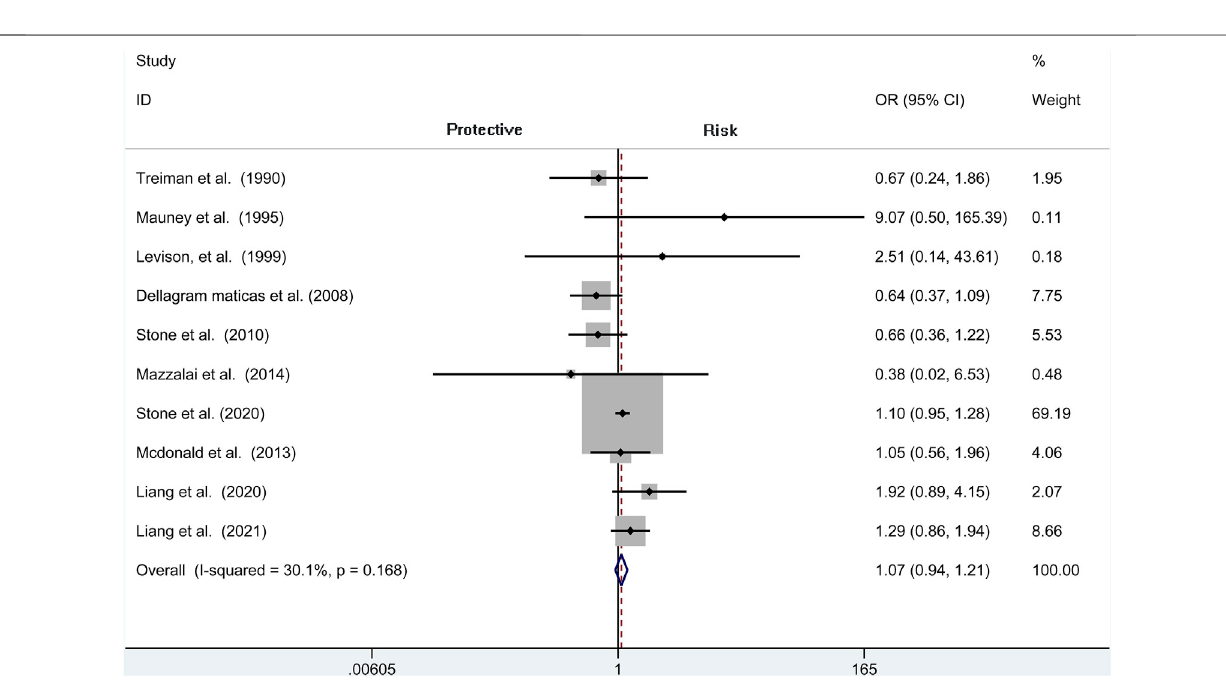
FIGURE 7 | Forest plot for meta-analysis of the incidence of